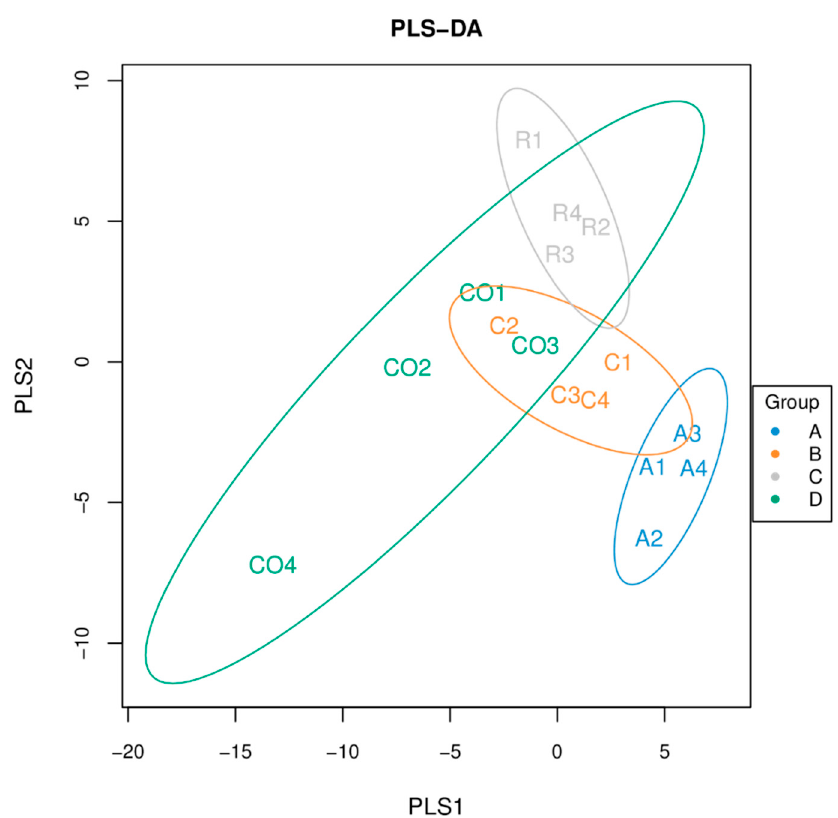
Figure 9. Partial least square discriminant analysis (PLS–DA) chart. Note: Each point represents a sample, the points with the same color belong to the same group, and the points of the same group are marked with an eclipse. If the samples belonging to the same group are closer to each other and the distance between the points of different groups is farther, the better the classification model. (A: alfalfa, B: cornstalk, C: rice straw, D: control).